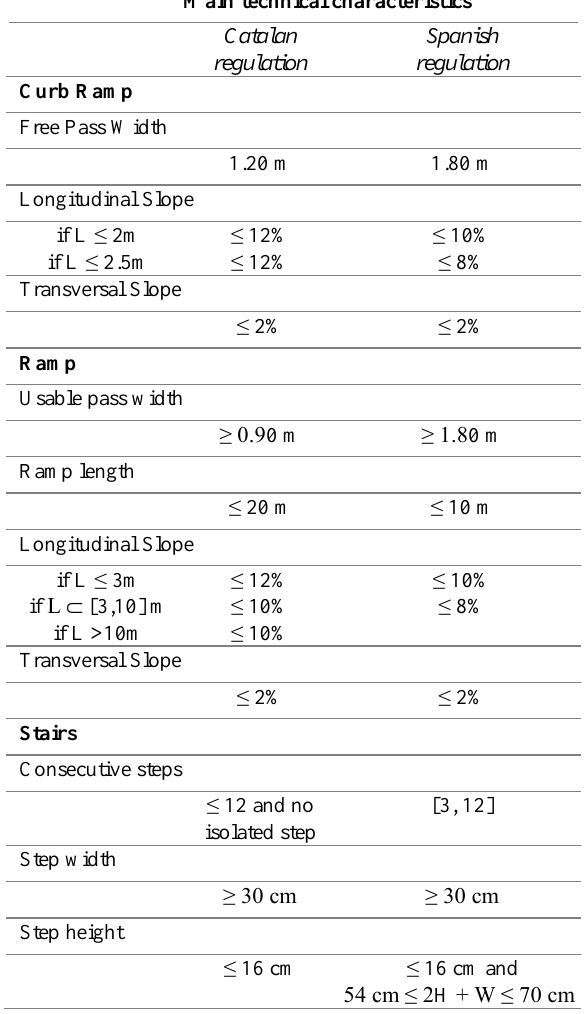
Table 1. Required technical characteristics of curb ramp, ramp and stairs in terms of accessibility according to Catalan and Spanish